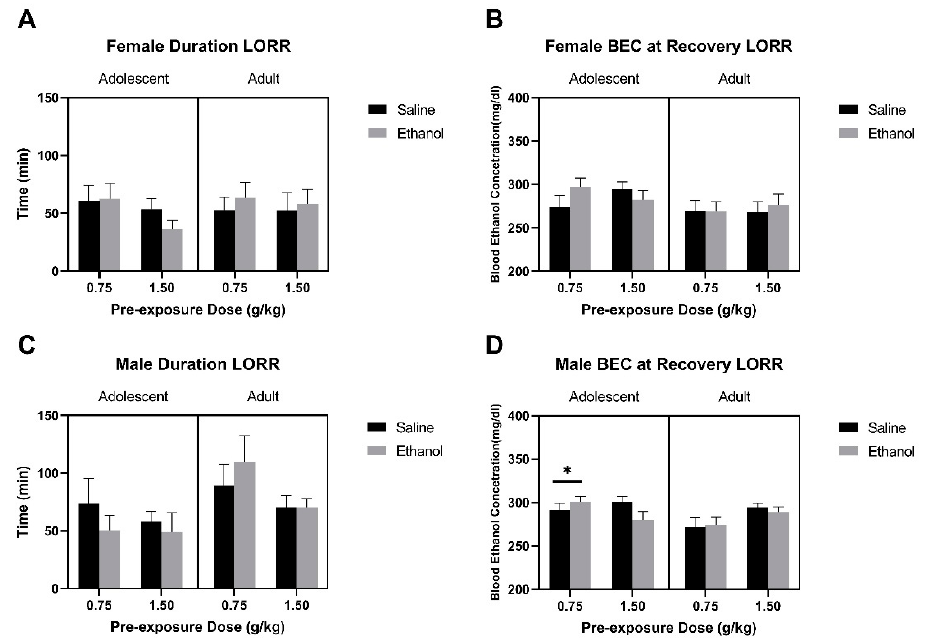
Figure 5. Data are presented as duration (min) of loss of righting reflex (Panels A , C ) and blood ethanol concentration (mg / dL) at recovery of LORR (Panels B , D ) following administration of 3.0 g / kg i.p. for male and female rats exposed to 0.75 or 1.5 g / kg ethanol or saline during adolescence or adulthood. * indicates adolescent is significantly higher than adult. Table 7. Table for ANOVA results for loss of righting reflex